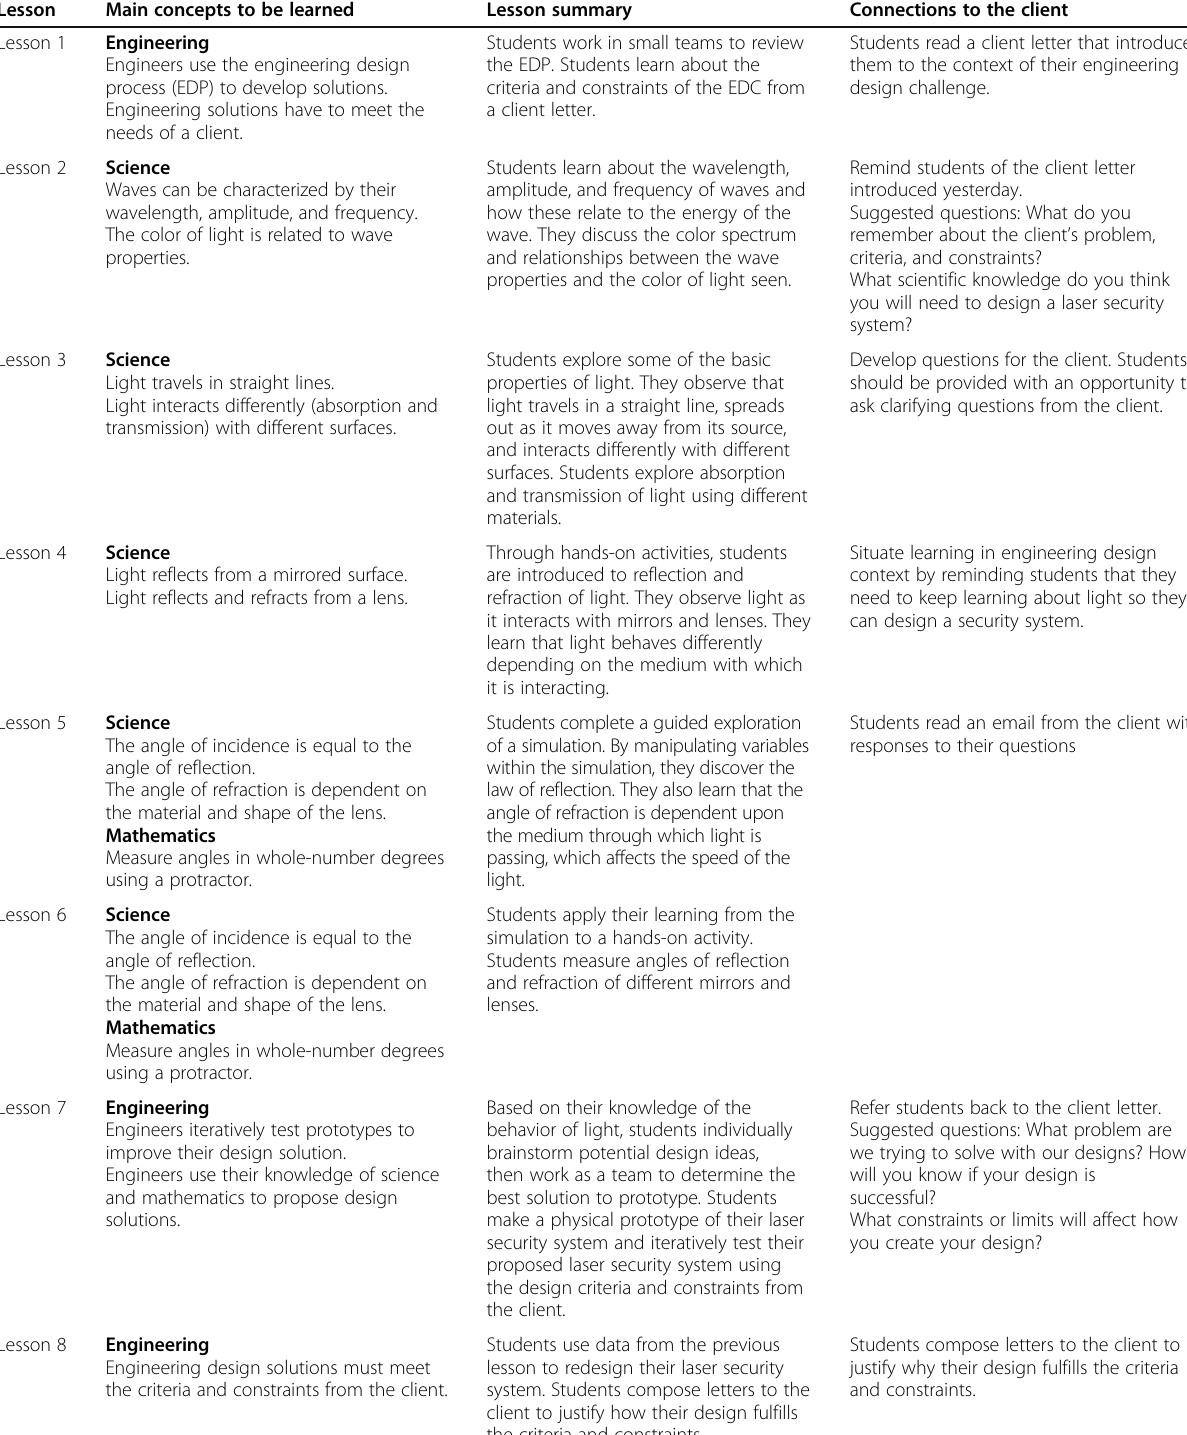
Table 3 Museum security lessons and main concepts Lesson Main concepts to be